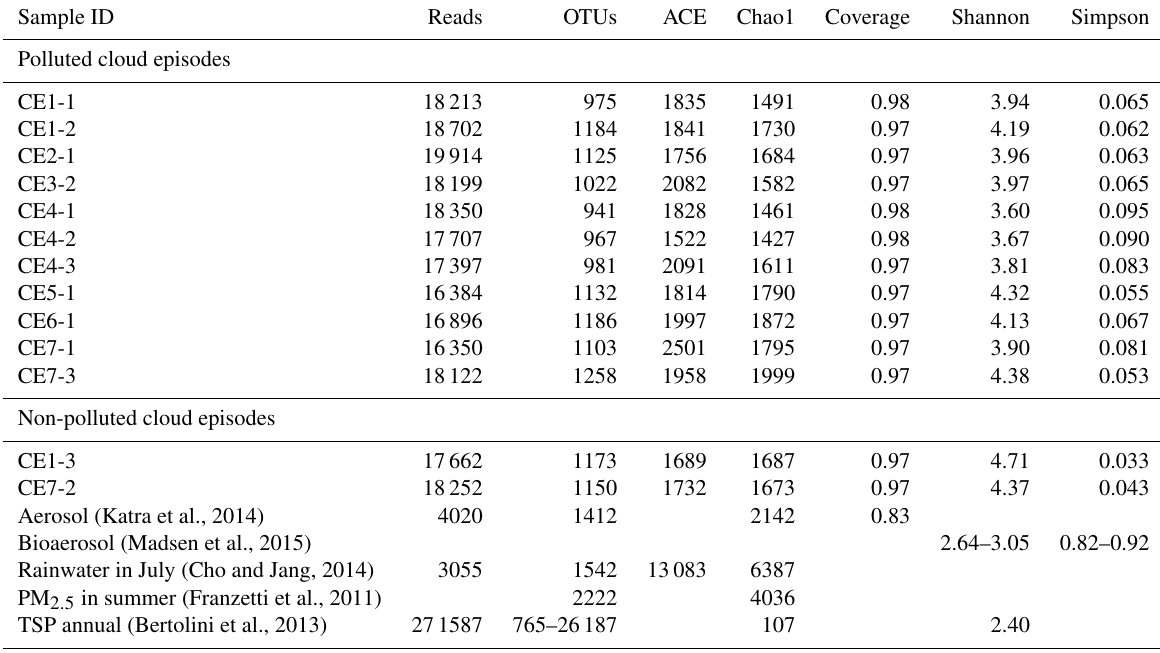
Table 2. Summary of bacterial diversity and richness of cloud water.